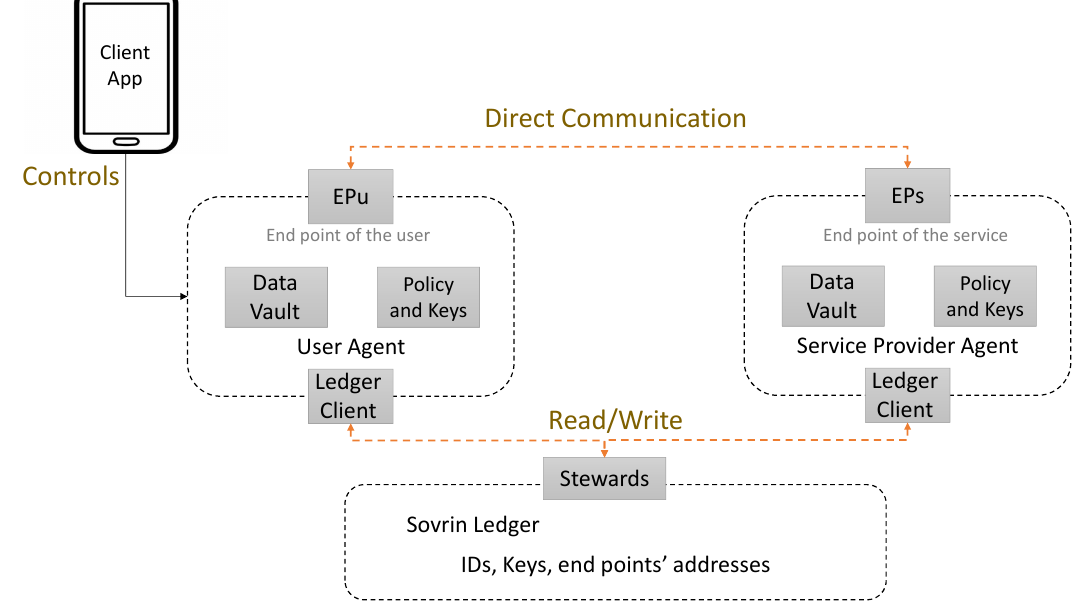
Figure 3. The architecture of the Sovrin identity management